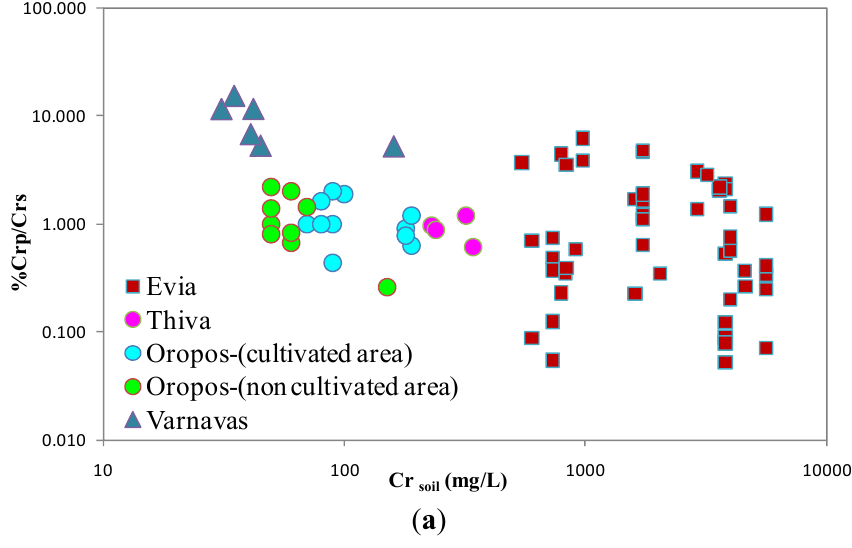
Figure 5. Variation of the accumulation factor [(% metals in plants × 100)/metal in soil] for Cr versus that for Fe ( a ); and versus Cr content in corresponding soil ( b ). Data from Table 3